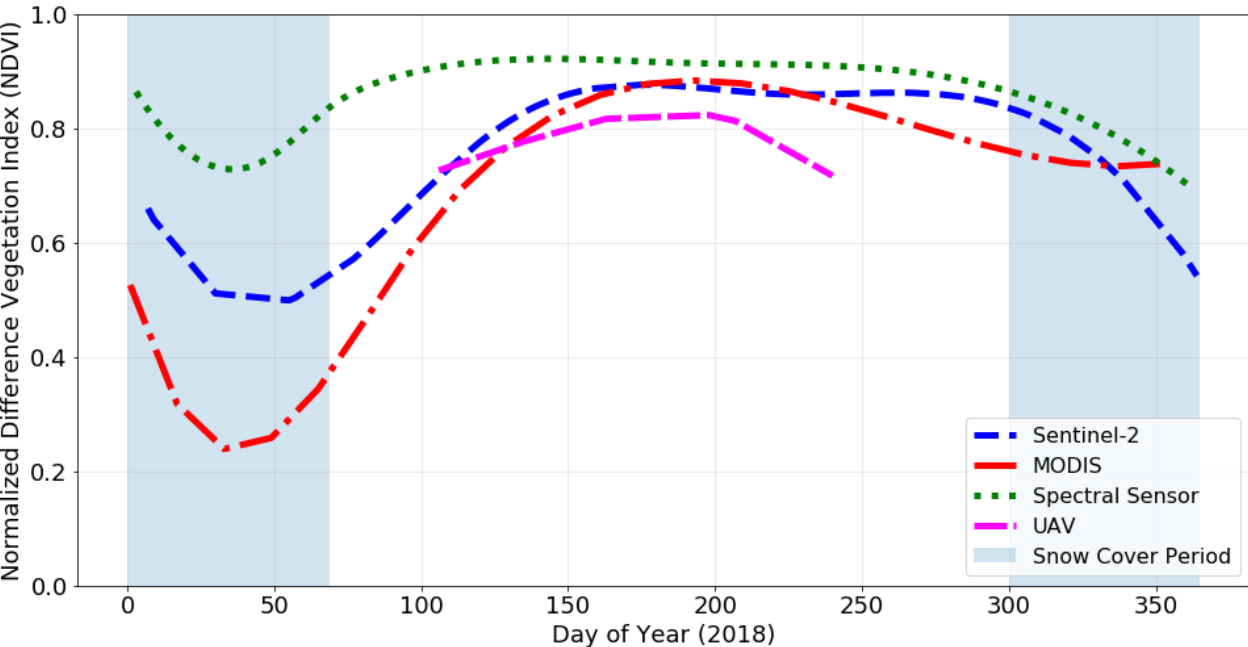
Figure 10. NDVI values comparing seasonal trends from Sentinel-2 NDVI , MODIS NDVI , SRS NDVI and UAV NDVI . All the NDVI values are computed for the ground projected footprint of the SRS (dashed red polygon in Figure 6). According to the Pearson’s regression analysis, the NDVI values from all sensors were positively correlated with each other (Table 4). The correlation between UAV NDVI and MODIS NDVI was the lowest (r = 0.75; RMSD = 0.08), while the highest correlation was found between MODIS NDVI and Sentinel-2 NDVI (r = 0.92; RMSE = 0.08), indicating a better fit between the two satellite datasets.